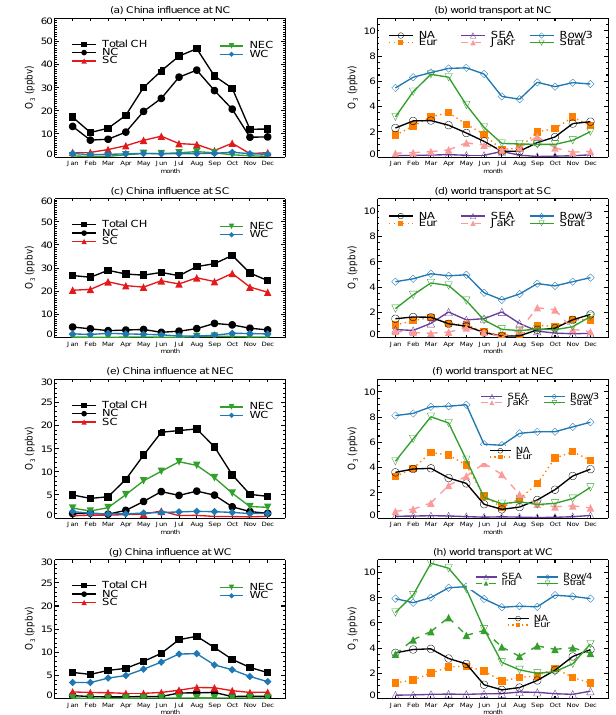
Fig. 10. Monthly mean mixing ratios of tagged ozone tracers over the four Chinese regions. Chinese tracers are shown in the left pan- els (a, c, e, g) and non-Chinese tracers in the right panels (b, d, f, h) . For simplicity, tracers with little seasonality or minimal impact on the receptor regions are not displayed in the figure. Note the different scale of the y-axis between the left and right